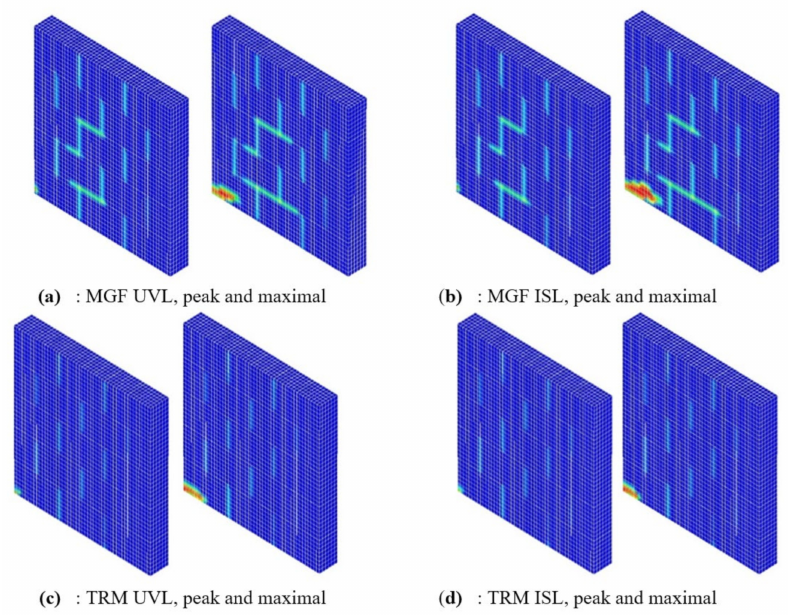
Figure 14. Compressive damage at peak and maximal displacement for the ( a ) MGF UVL, ( b ) MGF ISL, ( c ) TRM UVL, and ( d ) TRM ISL